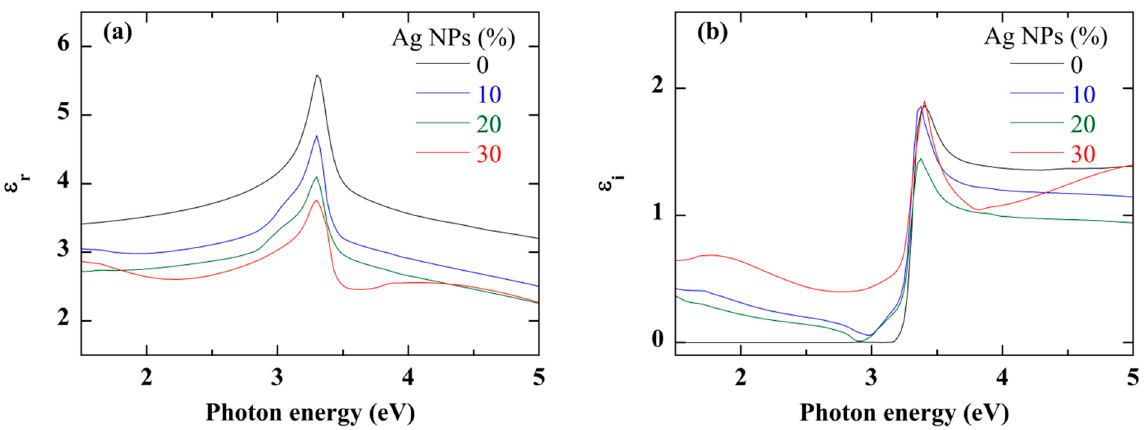
Figure 10. Real part ( a ) and imaginary part ( b ) of the dielectric function of the ZnO/Ag(NPs) nanocomposite film loaded with different contents of Ag NPs.